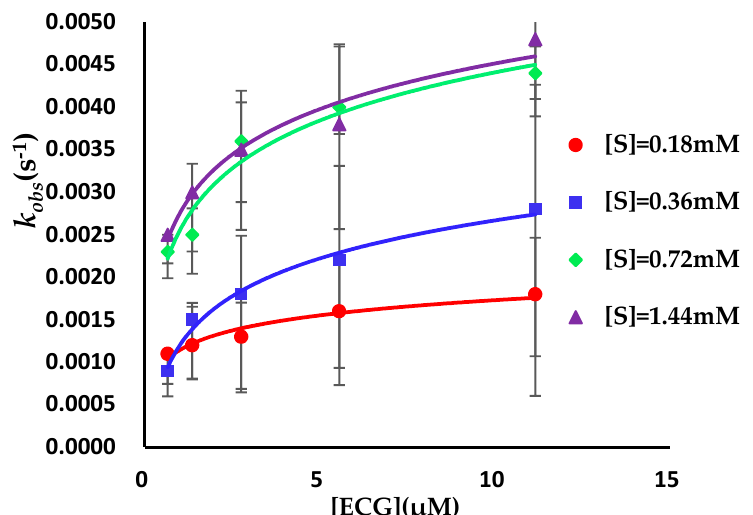
Figure 4. k obs values against AGH as a function of ECG concentrations in the presence of substrate at four various concentrations. The substrate concentrations were 0.18, 0.36, 0.72 and 1.44 mM, and the ECG concentrations were 0.7, 1.4, 2.8, 5.6, 11.2 µ M. The observed k obs hyperbolically rely on the ECG concentration, suggesting an induced-fit mechanism. Table 1. Summary of true a ffi nity and binding kinetics of epicatechin gallate (ECG) and epigallocatechin gallate (EGCG) against α -glucosidase